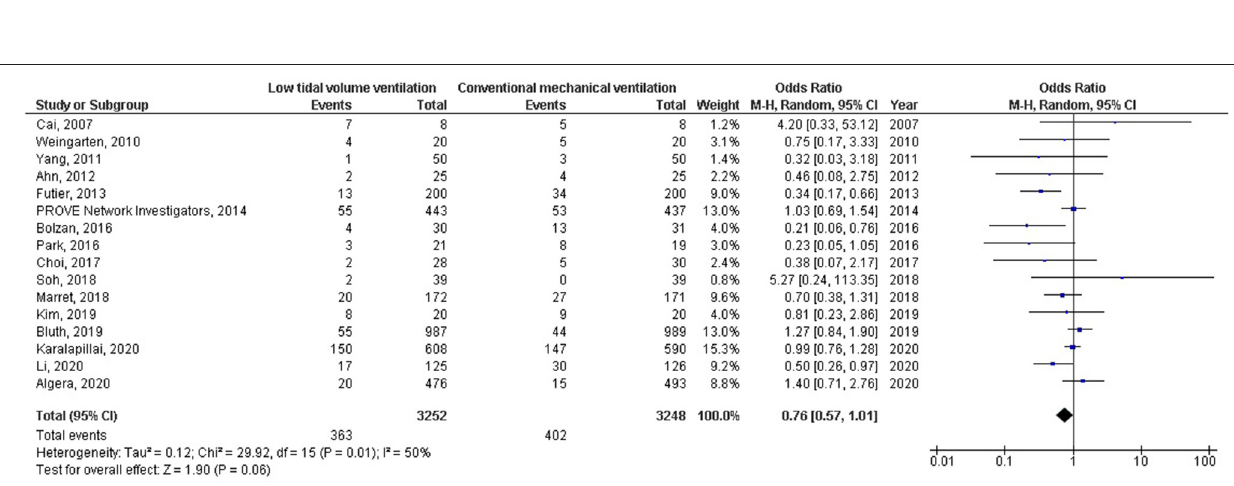
Frontiers in Surgery |